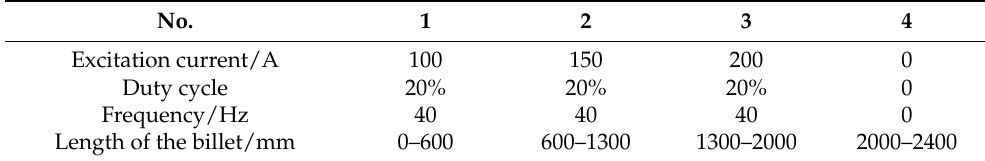
Table 2. Current parameters used in the experiment.